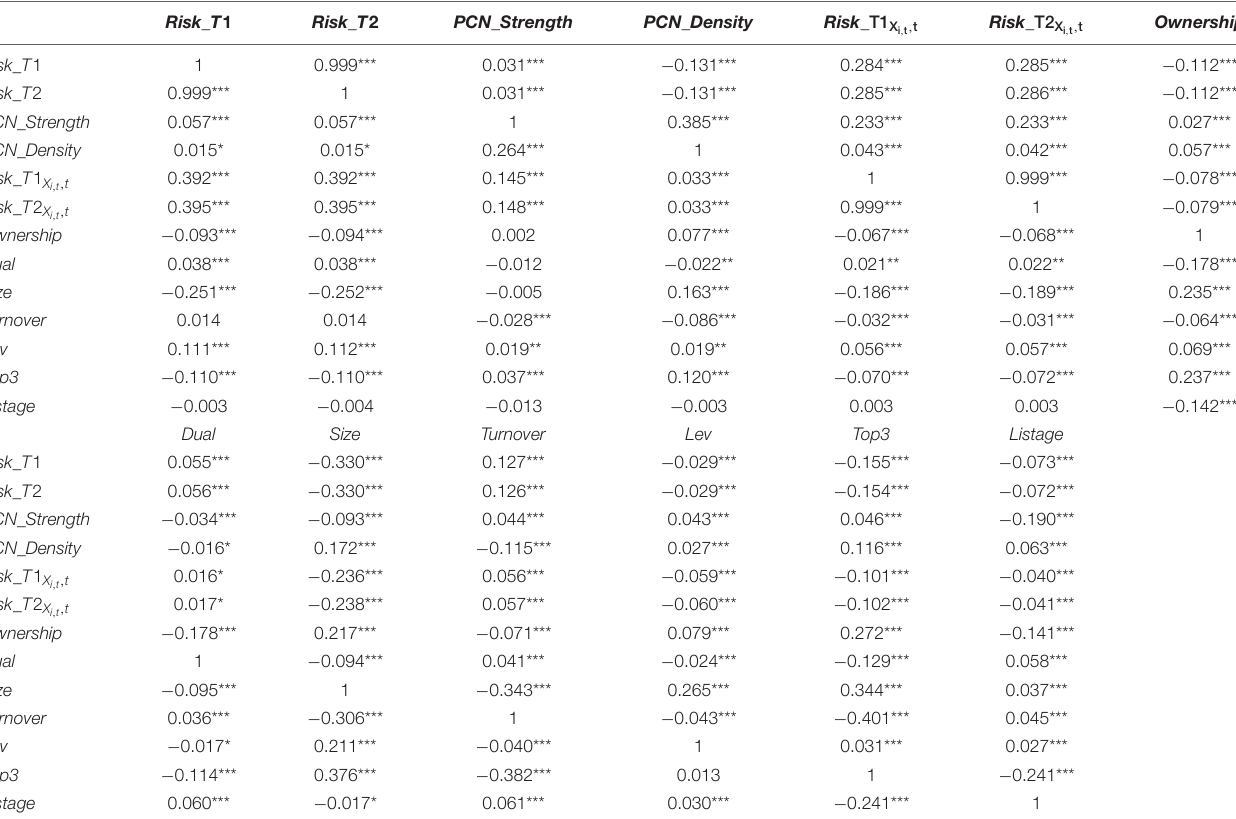
TABLE 3 | The correlation coefficient of